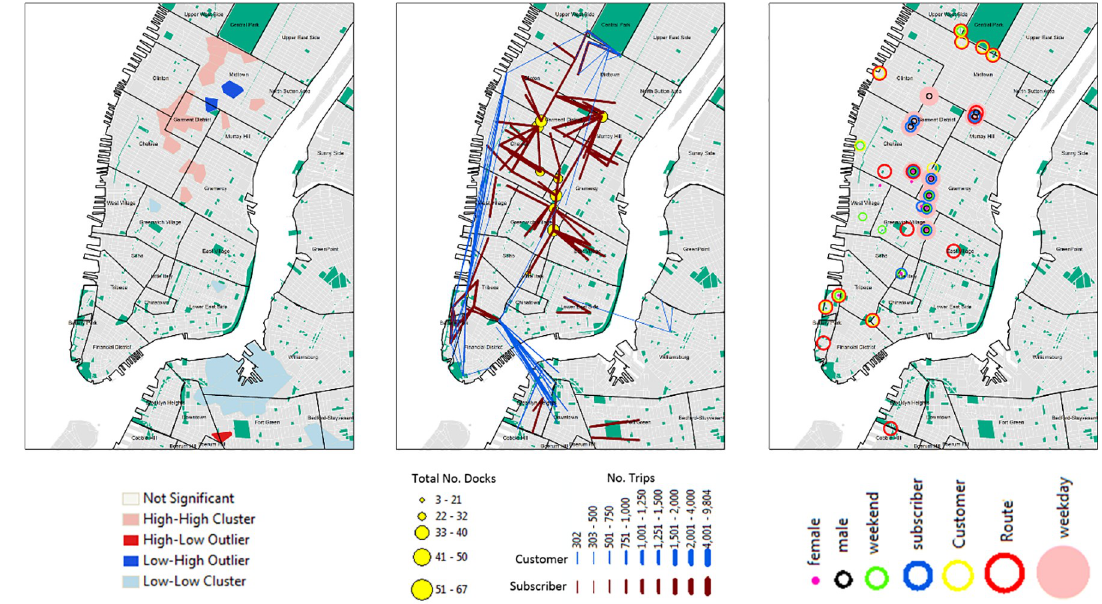
Fig 4. (A) Distribution of bike stations and clustering of bikes (based on total number of docks at each bike station); (B) most popular start locations (showing the top 10 start stations) and origin-destinations (top 100 routes used by subscribers and customers); and (C) top ten start stations by gender (male and female), user type (subscriber and customer), day of the week (weekend (Saturday and Sunday) and weekday (Monday through Friday)) and route. (Data Sources: CitiBike Stations, NYC Parks, Census Blocks, NYC Neighborhood Names (S2